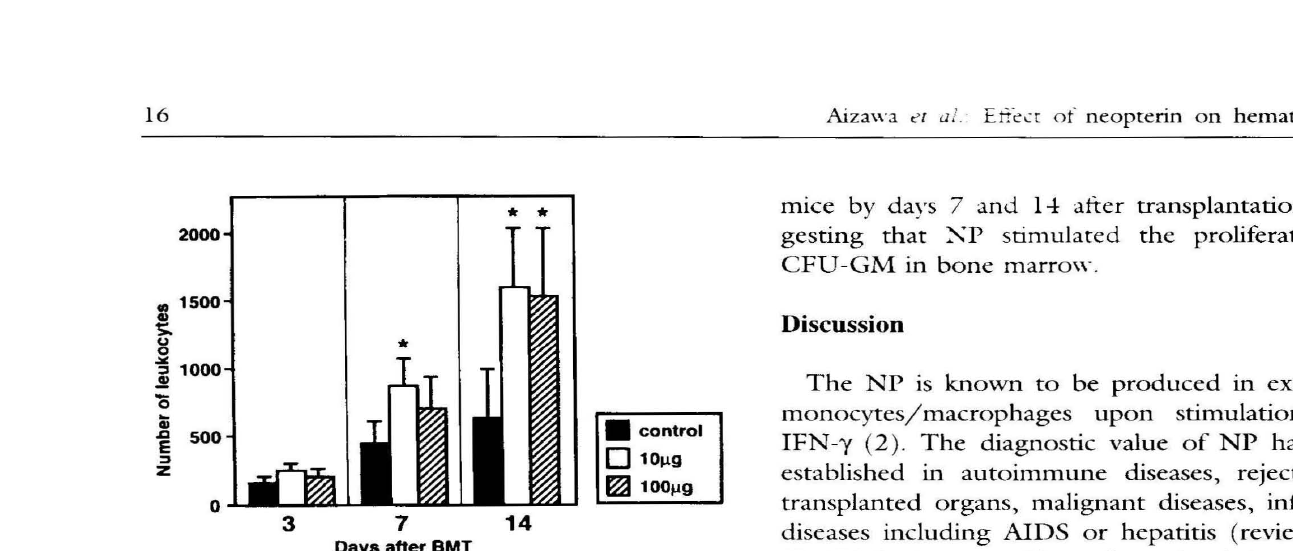
Pigun: S. The numher of peripheral leukocytes in hone marrow transplanted mice. One x 101i hone marrow cells were transplanted with or without NP and the recovery of peripheral leukocytes was investigated. Each bar represents the mean ± JSD obtained from five mice in dividually analyzed. *Significant increase (p<O.OS) with respect to NP non-treated mice.